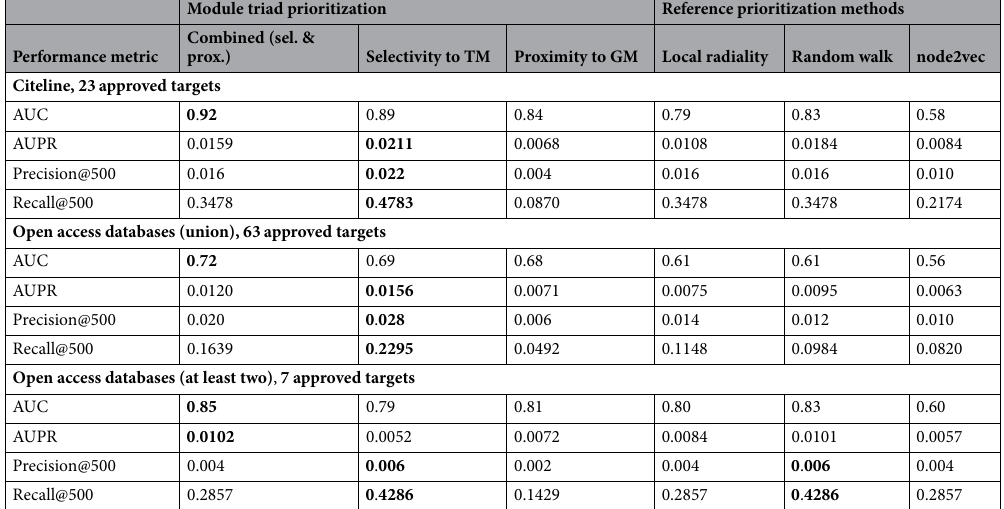
Table 1. Performance of the proposed module triad method and other network-based target prioritization methods on recovery of known approved targets in ulcerative colitis. Known approved targets are derived from Citeline database, as well as the three open access databases. Best performing methods are highlighted in